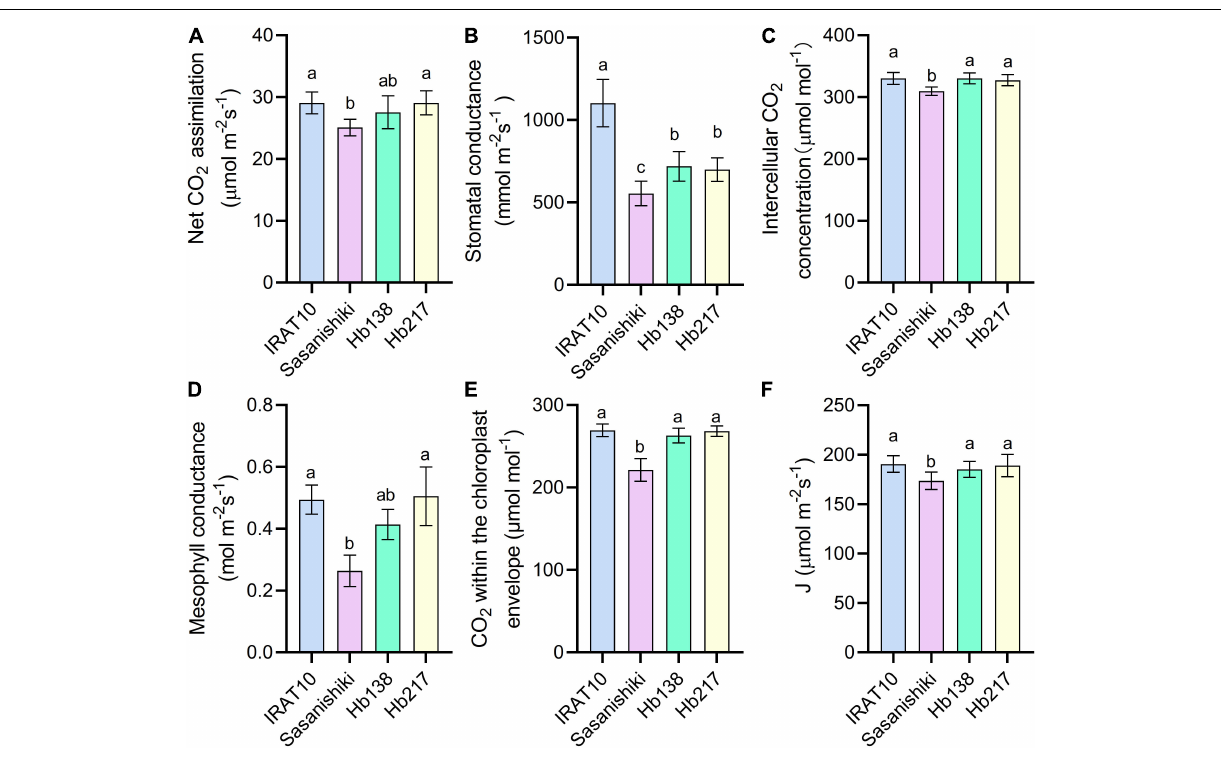
FIGURE 4 | Net CO 2 assimilation rate (An) (A) , stomatal conductance to water (g S ) (B) intercellular CO 2 concentration (Ci) (C) mesophyll conductance (g m ) (D) , CO 2 concentration within the chloroplast envelope (Cc) (E) , and electron transport rate (J) (F) in the flag leaves of tested varieties. Values are means ± standard error. Different letters indicate significant statistical differences among tested varieties at the 0.05 probability